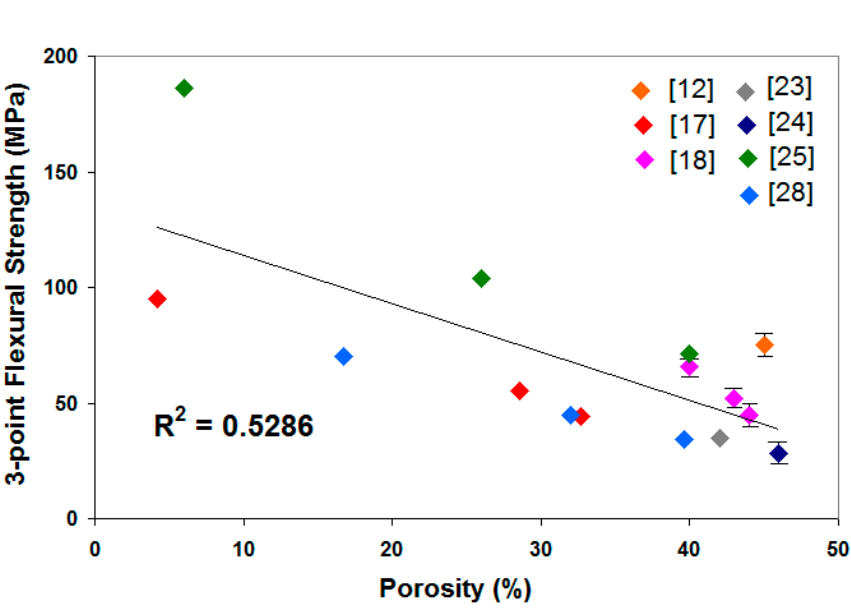
Figure 2. 3-point flexural strength correlation with porosity.